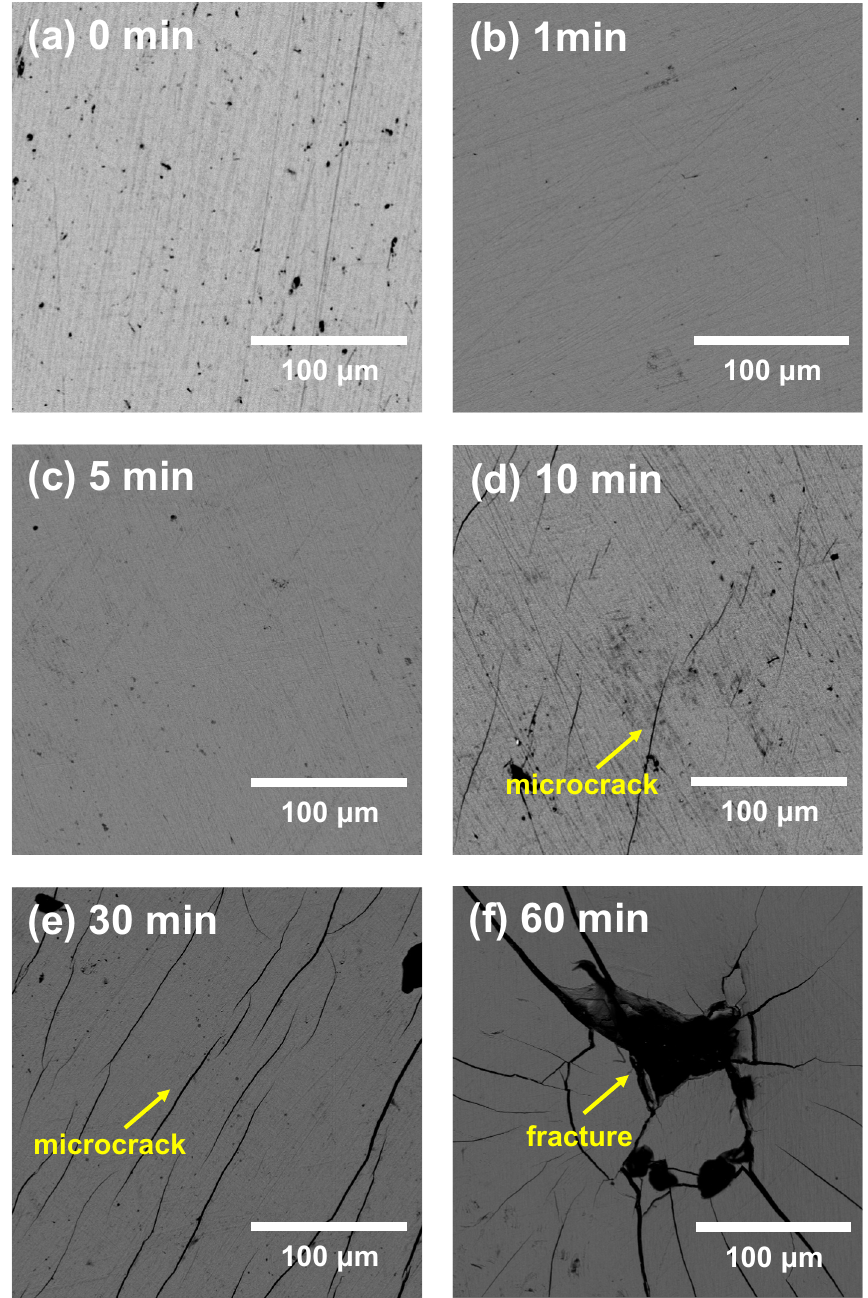
Figure 2. Top view SEM images of the TiZr alloy specimens heat-treated at 600 °C for ( a ) 0 min, ( b ) 1 min, ( c ) 5 min, ( d ) 10 min, ( e ) 30 min, and ( f ) 60